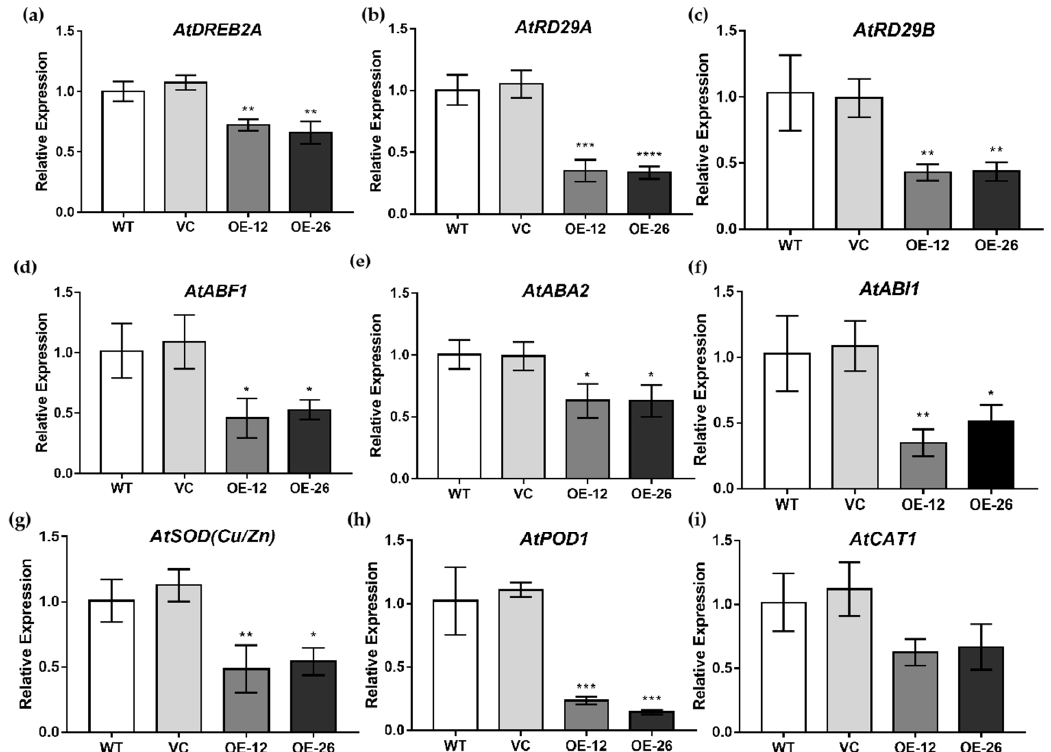
Figure 7. Expression levels of stress-related genes in TaWRKY133 transgenic Arabidopsis, WT and VC under drought treatment. AtDREB2A ( a ), AtRD29A ( b ), AtRD29B ( c ), AtAF1 ( d ), AtABA2 ( e ), AtABI1 ( f ), AtSOD(Cu/Zn) ( g ), AtPOD1 ( h ), AtCAT1 ( i ) (* p < 0.05, ** p < 0.01, *** p < 0.001 and **** p < 0.0001). 2.6. BSMV-Mediated TaWRKY133 Gene Silencing Increased Drought Tolerance